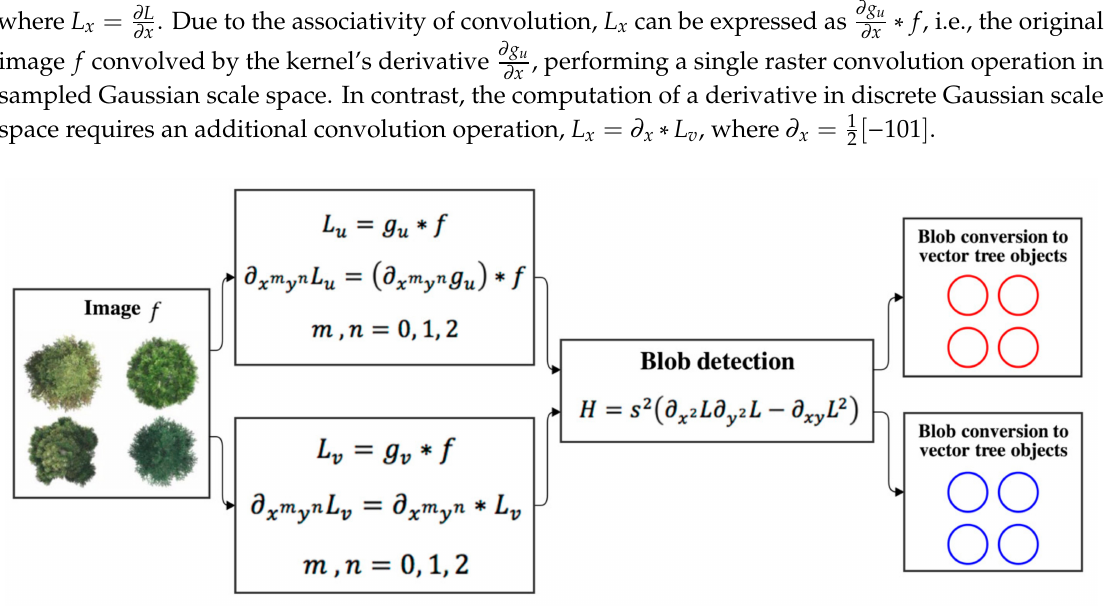
Figure 3. Schematic diagram of scale space for blob detection from either the two-dimensional sampled Gaussian kernel, indexed by u , or the two-dimensional discrete Gaussian kernel, indexed by v . The detected red and blue blob objects are from the sampled and discrete Gaussian kernels,